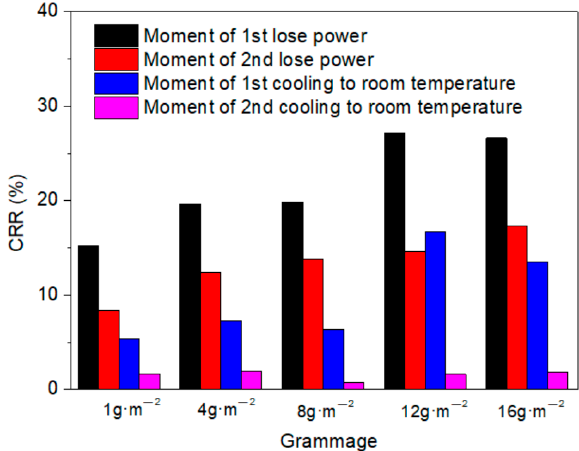
Figure 15. CRR of membranes with different grammages in the heating process.